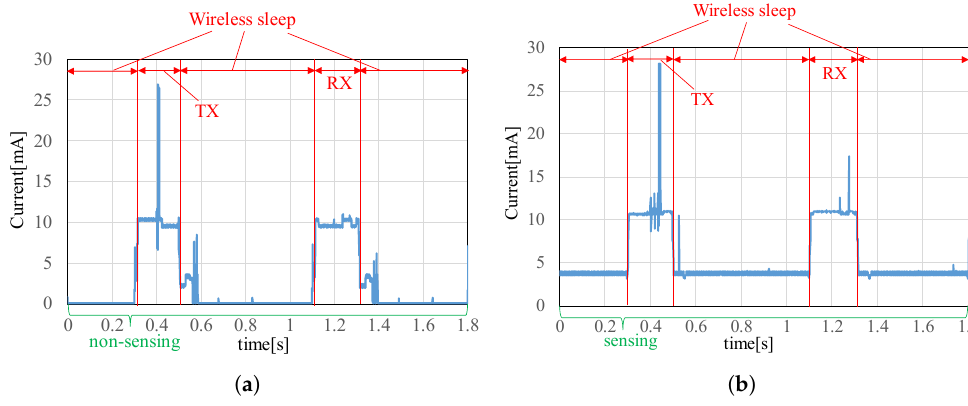
Figure 11. Power consumption result:( a ) non-sensing, ( b ) sensing. Table 1. Mean current and mean power consumption data results. Time